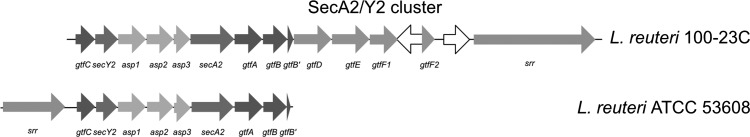
Schematic representation of the accessory SecA2/Y2 clusters from L. reuteri 100-23C and ATCC 53608.